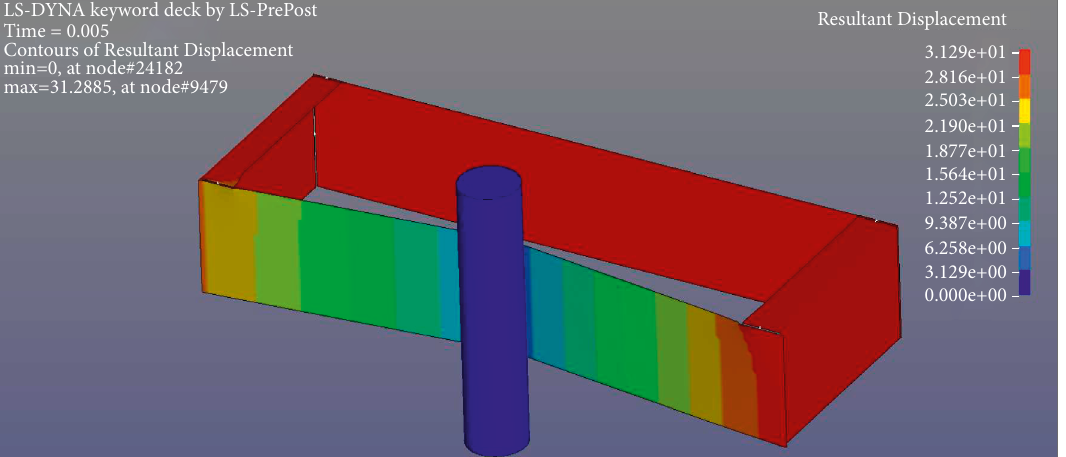
Figure 15: Resultant